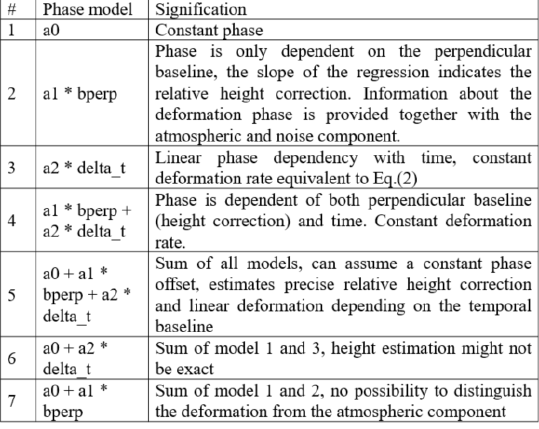
Table 2: Different phase models considered in this work (after Werner et al., 2003).